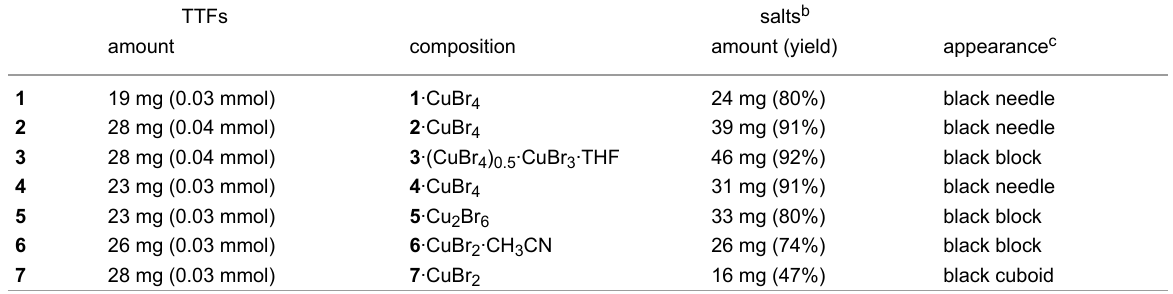
Table 2: Preparation, composition, yield, and appearance of the salts. a